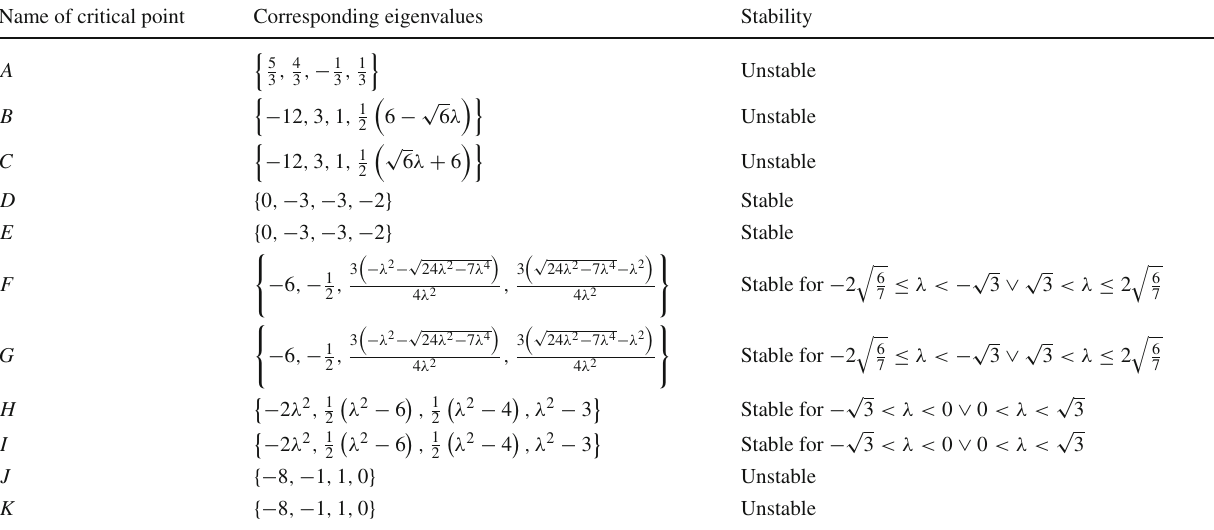
Table 12 Eigenvalues and stability of eigenvalue at corresponding critical point Name of critical point